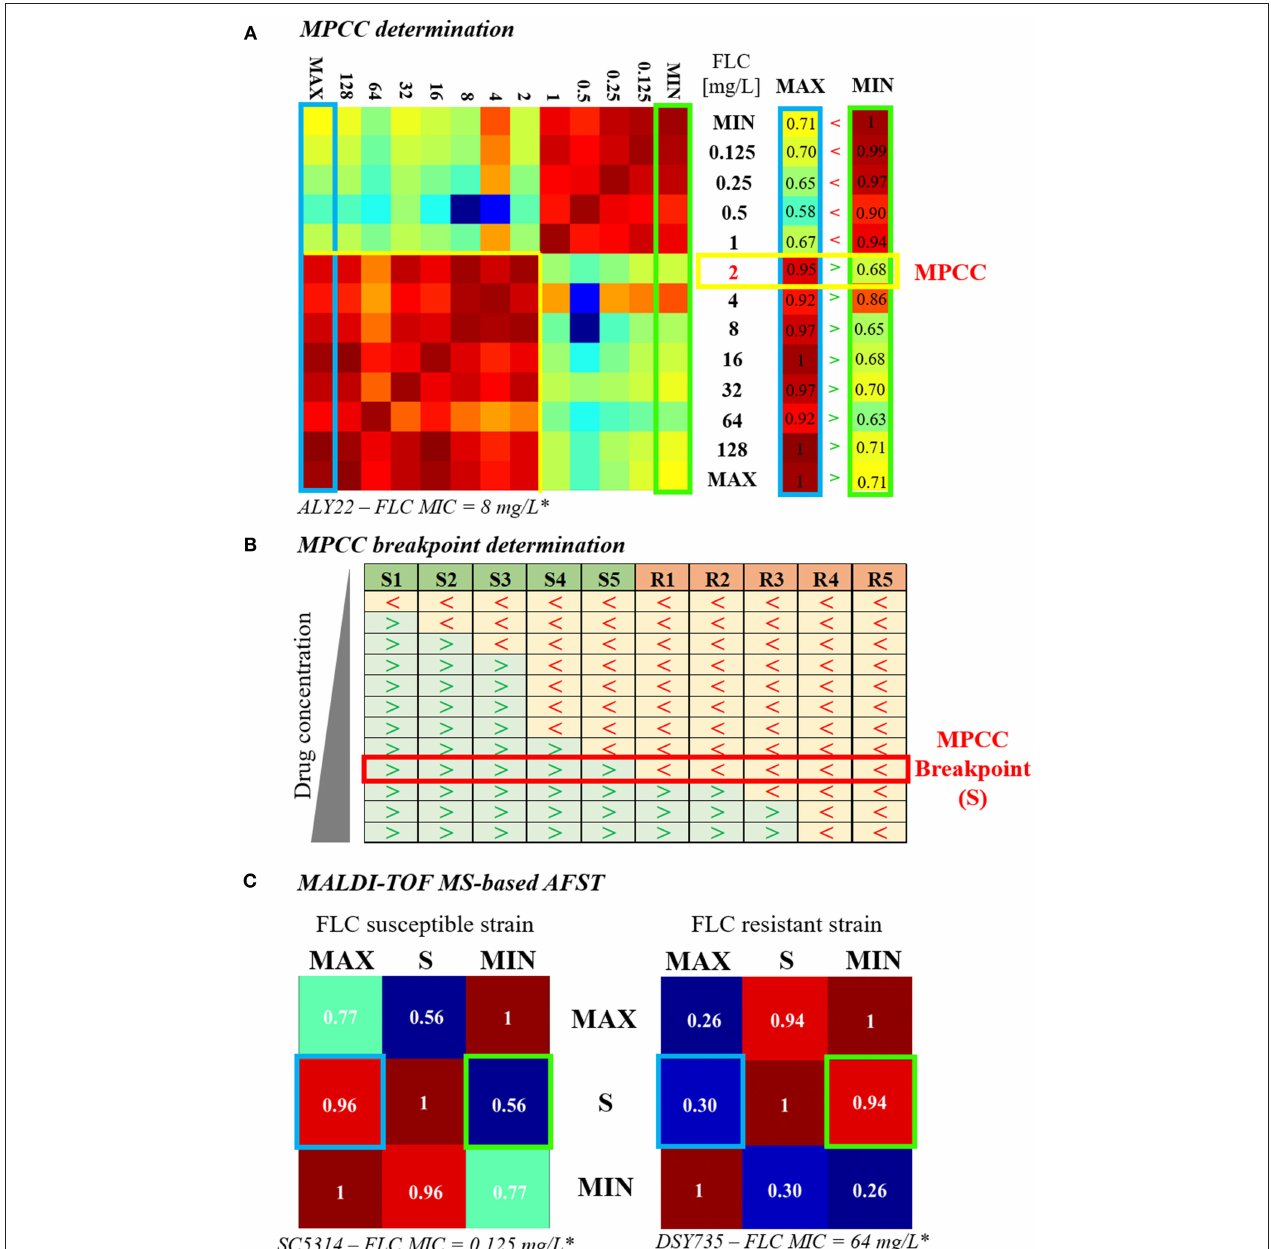
FIGURE 1 | Evolution of the MALDI-TOF MS-based AFST assay. (A) MPCC determination. A 13 × 13 CCI matrix (personal data) is generated by comparing the spectra obtained after exposure to increasing concentrations of fluconazole (0 = MIN to 256 µ g/mL = MAX), as explained in De Carolis et al. (2012). Red gradient corresponds to strong correlations and blue gradient corresponds to weak ones. The first and the last column of the CCI matrix, namely the comparison of the spectra at all concentrations with the spectra at MAX (blue box) and at MIN (green box), respectively, are isolated. The MPCC (yellow box) corresponds to the fluconazole concentration at which the value of the MAX column is higher ( > ) than the value of the MIN column, at the same concentration. (B) MPCC breakpoint determination. MPCC values of several susceptible (S1 to S5) and resistant (R1 to R5) strains from the same Candida spp. are compared. “ > ” indicates that the spectra at the given concentration is more similar to the spectra at MAX, whereas “ < ” indicates that the spectra at the given concentration is more similar to the spectra at MIN. The MPCC breakpoint concentration (S) correspond to the fluconazole concentration which allow the best discrimination between the resistant and the susceptible strains (red box), as explained in De Carolis et al. (2012). (C) MALDI-TOF MS-based assay. A 3 × 3 CCI matrix is generated by comparing the spectra at MAX, S, and MIN, as presented in Vella et al. (2013). The results of the correlation between S and MAX (blue box) and S and MIN (green box) are compared. The strain is assessed as susceptible if the result of the correlation between S an MAX is higher than the result of the correlation between S and MIN (left matrix, personal data), whereas the strain is assessed as resistant if the result of the correlation between S an MAX is lower than the result of the correlation between S and MIN (right matrix, personal data). * Lohberger et al. (2014), FLC = fluconazole.